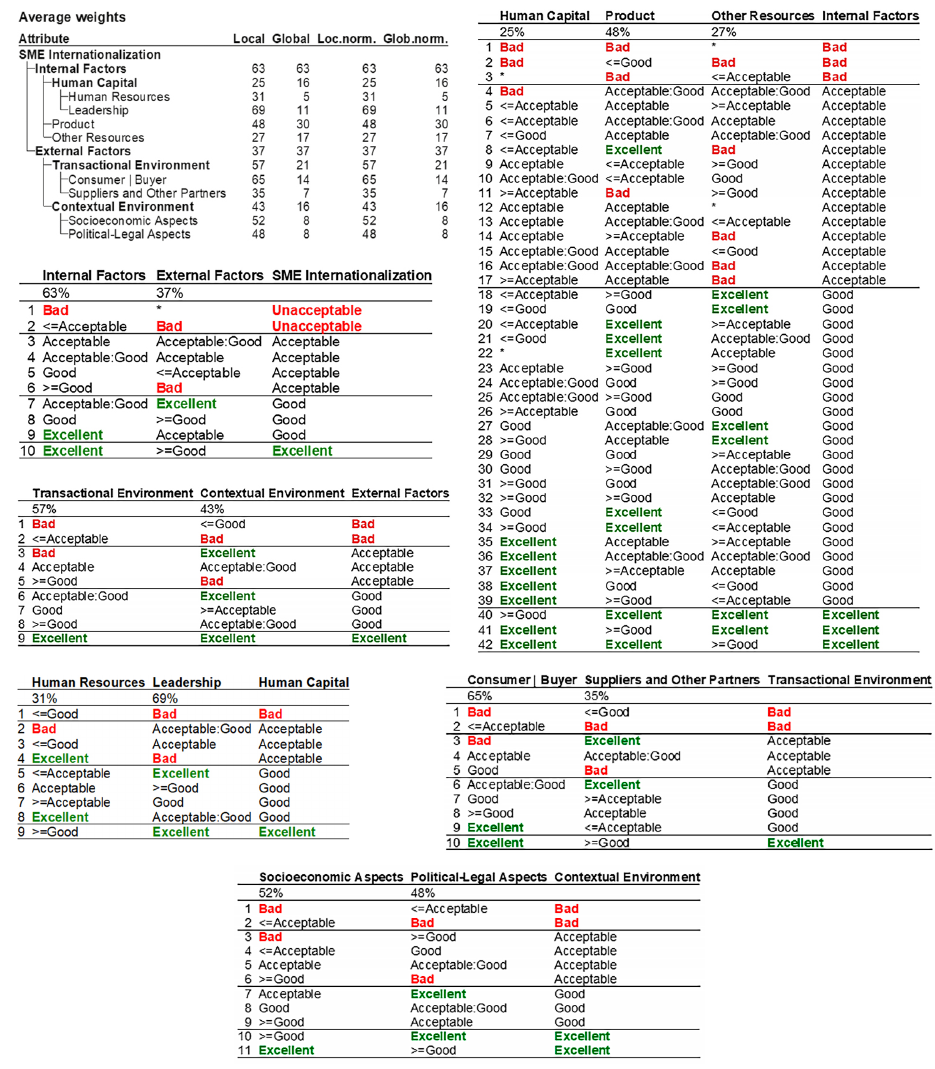
Figure 8. Complex decision rules and weights